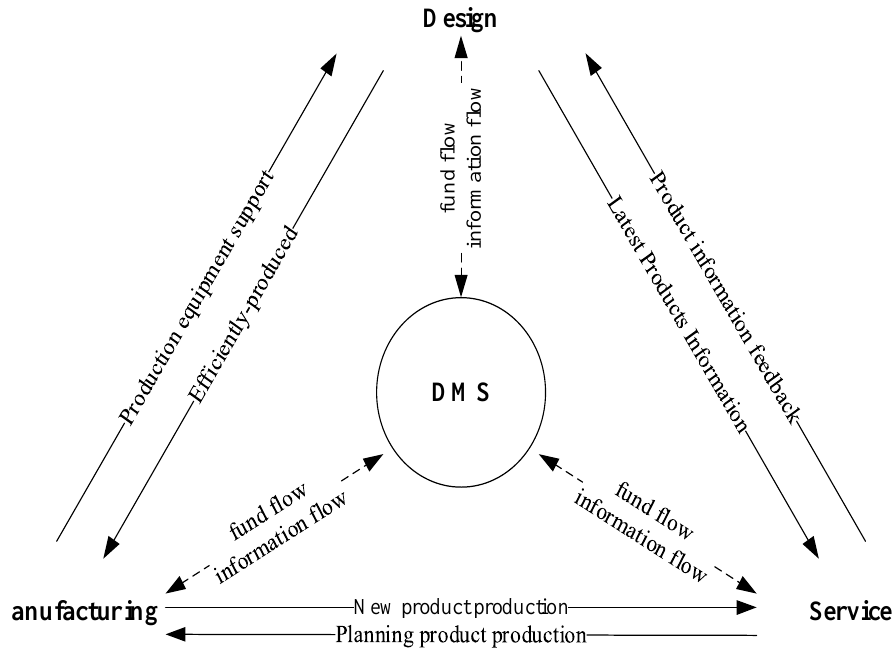
Figure 3. Design–Manufacturing–Service integration framework.